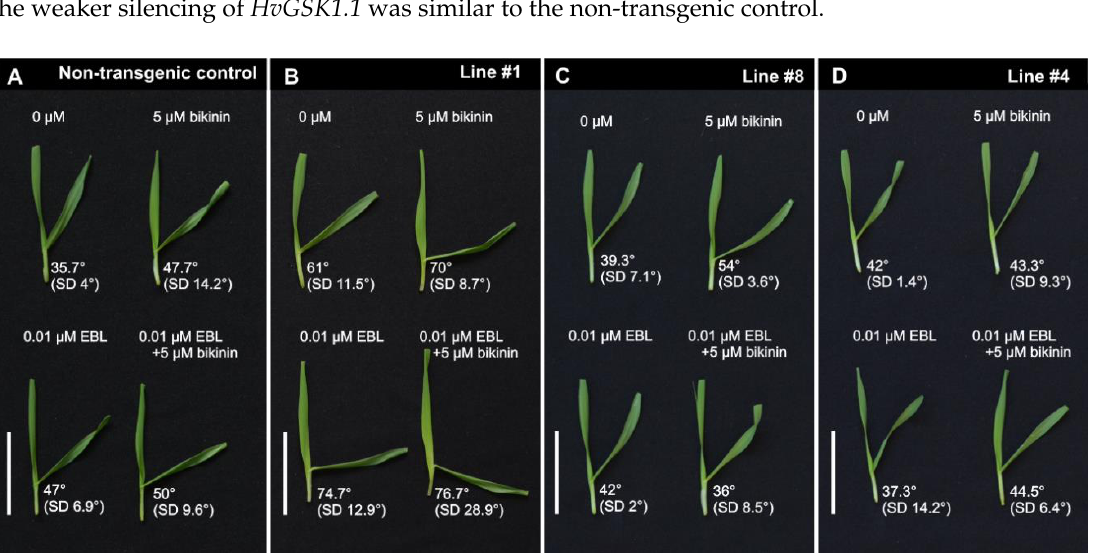
Figure 3. Representative pictures of leaf fragments treated with 24-epibrassinolide (EBL) 0.01 µ M, bikinin 5 µ M, and EBL (0.01 µ M) and bikinin (5 µ M) applied together. ( A )–the non-transgenic control plants, ( B )–line #1 with strong silencing of HvGSK1.1 , ( C )–line #8 with intermediate silencing of